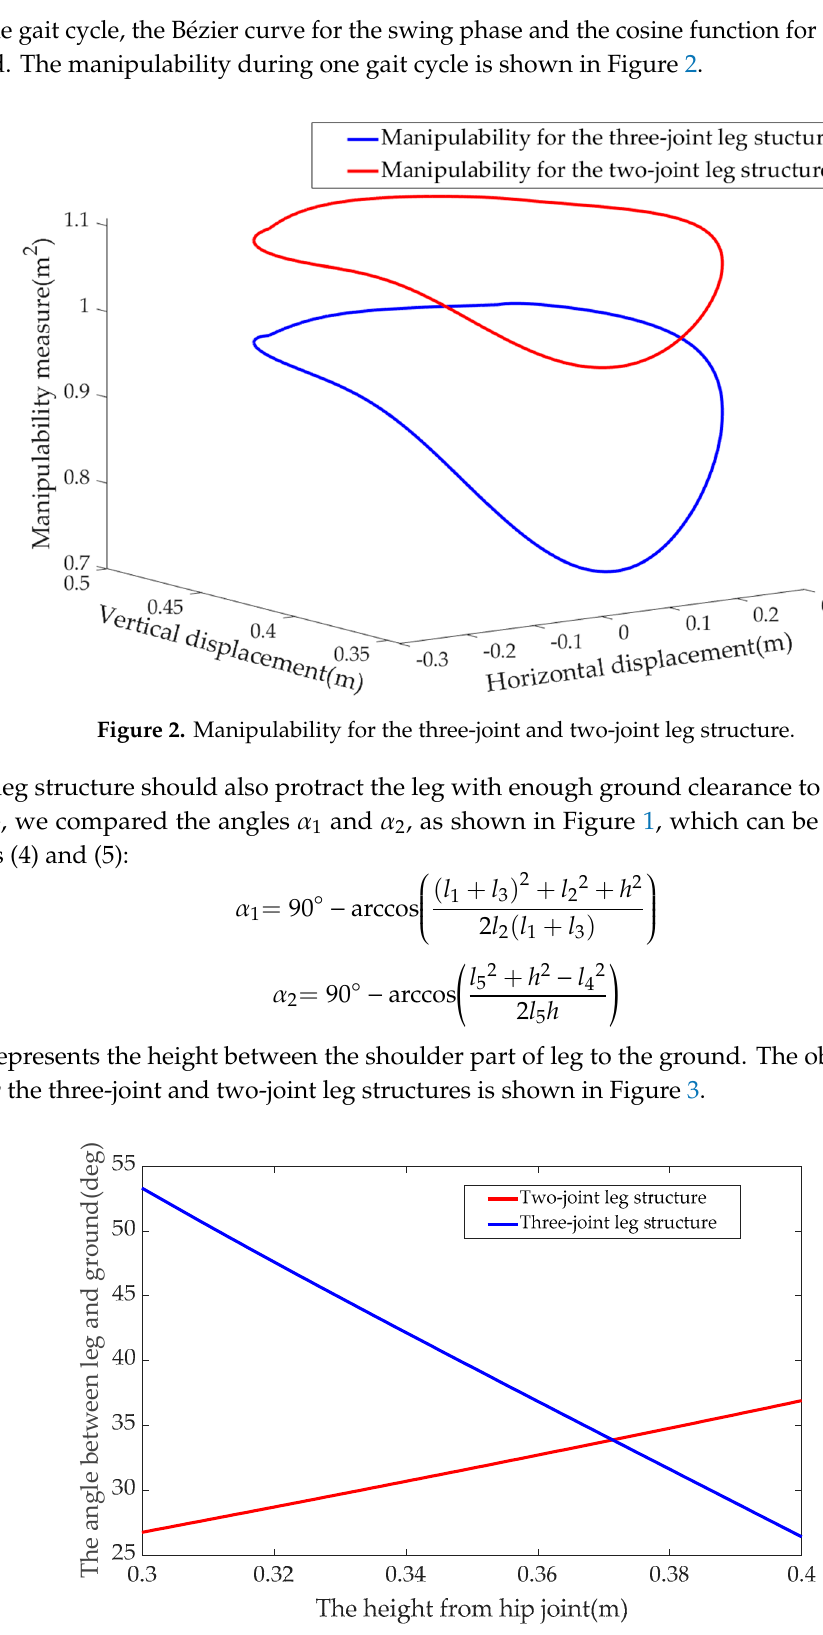
Figure 3. Obstacle avoiding ability of the three-joint and two-joint leg structures.